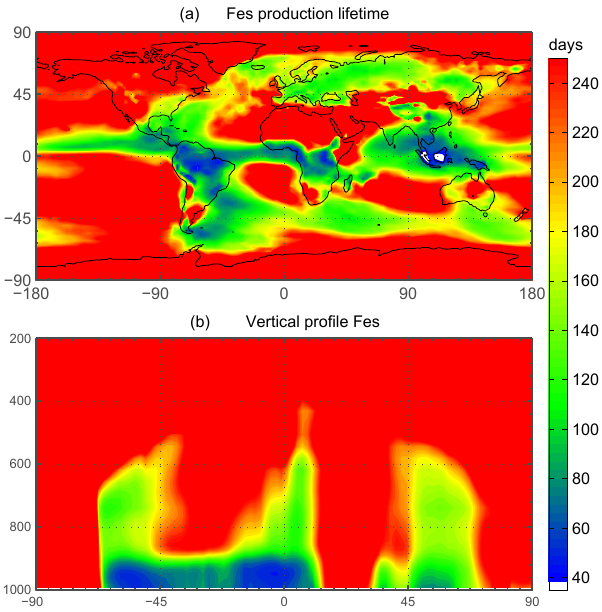
Figure 6. Spatial distribution of annually averaged turnover time of insoluble iron (days) defined as the total insoluble iron from dust and combustion aerosols divided by the production of soluble iron from insoluble iron (a) . Zonal distribution of annually averaged in- soluble to soluble iron turnover (days) (b) .